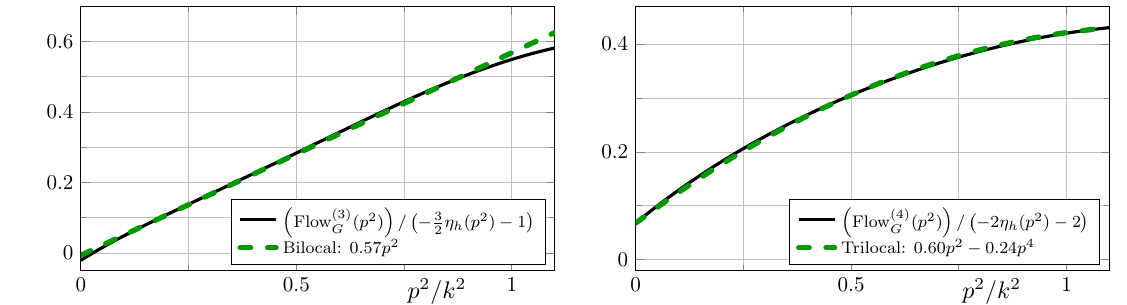
Fig. 2 Momentum dependence of the flow of the graviton three-point function (left) and the graviton four-point function (right) divided by ( − n η ( p 2 ) − n + 2 ) as defined in (26). The flows are evaluated at h 2 (μ,λ ,λ , g , g ) = ( − 0 . 4 , 0 . 1 , − 0 . 1 , 0 . 7 , 0 . 5 ) and λ 3 4 3 4 as well as g 6 = g 5 = g 4 . The flows have such a simple polynomial structure as long as all couplings λ n remain small, i.e. | λ n | (cid:2) 1. Impor-